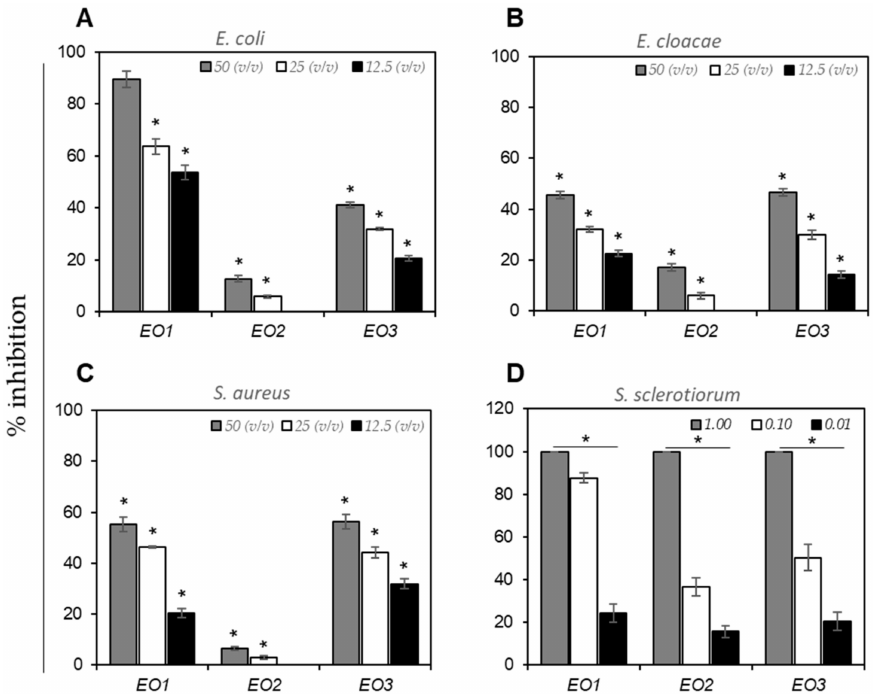
Figure 4. Antimicrobial activity of essential oil from O. gratissimum (EO1), O. tenuiflorum (EO2), and O. sanctum (EO3) against two-gram negative ( A ) Escherichia coli (ATCC 11775) and ( B ) Enterobacter cloacae , (ATCC 13047), gram-positive bacteria viz. methicillin resistant ( C ) Staphylococcus aureus (ATCC 33591), and plant fungal pathogen ( D ) S. sclerotiorum . The antibacterial activity of EOs is relative to antibacterial activity of Chloramphenicol (10 mcg). The analysis was performed in triplicate, and the error bar represent the standard deviation. The p -value indicate the statistical significance as determined through Student’s t -test (* p <